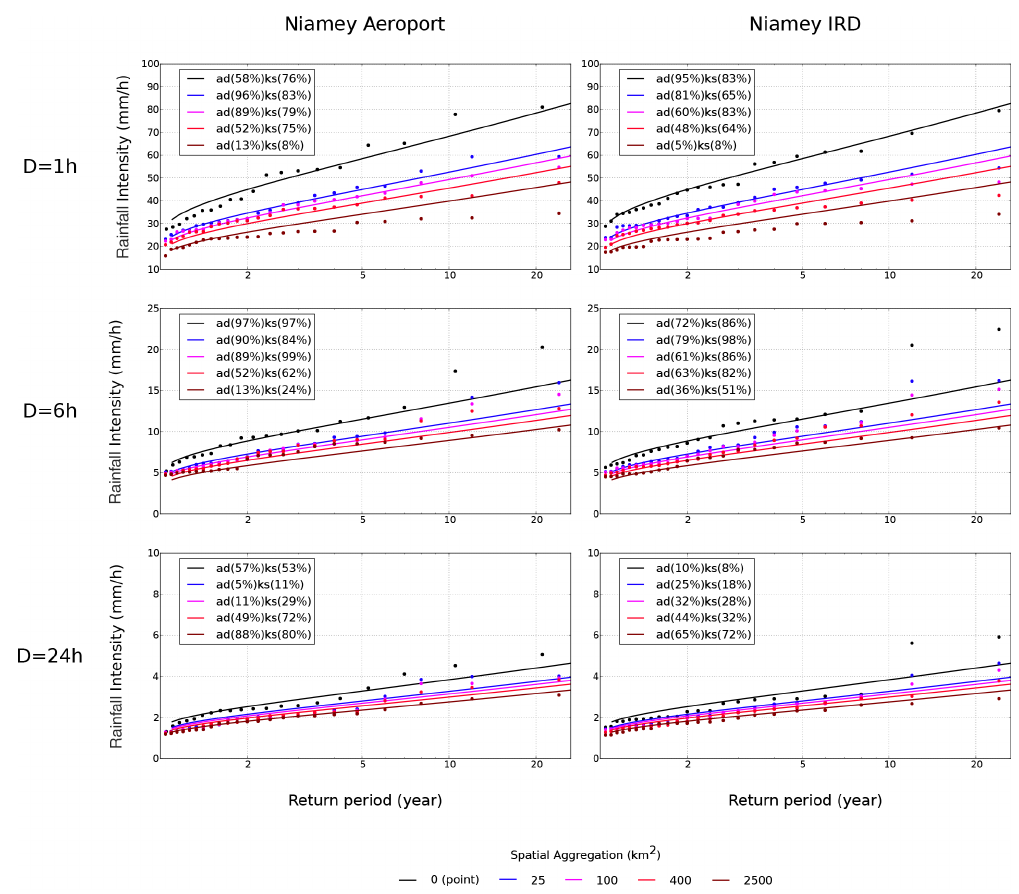
Figure 9. Empirical return level plot obtained at two rain gauges in comparison with the global IDAF model for different durations (1h, 6h, and 24h from top to bottom) and different spatial aggregations (from point to 2500km 2 ).